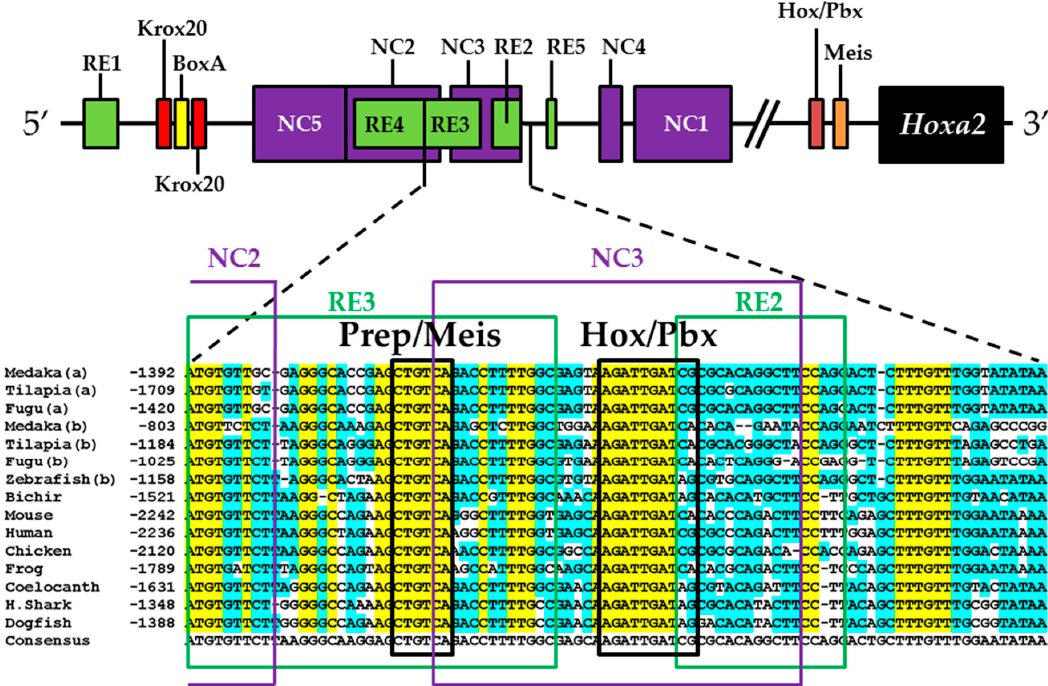
Figure 5. Comparative genomic sequence analysis of the 89 bp DNA fragment of the medaka hoxa2a UER(K20-RE5) (top sequence) that directs expression in r4 and the CNCCs. This sequence was compared to orthologous DNA sequences upstream of hoxa2a (denoted by a in parentheses after species name) and hoxa2b (denoted by b in parentheses after species name) of teleosts, Hoxa2 of tetrapods and Hoxa2 of coelacanth, horn shark and dogfish. Numbers correspond to genomic base pair positions relative to the ATG start site of the Hoxa2 genes. The schematic diagram above the sequences corresponds to the mouse Hoxa2 UER and the relative location of the 89-bp DNA fragment of the medaka hoxa2a r4/CNCC-specifying element. The schematic is not drawn to scale. Base pairs colored in yellow correspond to complete conservation at particular sites across all sequences examined. Base pairs colored in blue represent the majority of the sequences containing specific base pairs at specific sites. Purple boxed regions and green boxed elements correspond to neural crest and rhombomeric elements defined in the mouse Hoxa2 UER [27,28]. Black boxed regions correspond to transcription factor binding sites identified in this study. A consensus sequence was derived from the aligned sequences. NC, neural crest; RE, rhombomeric element.